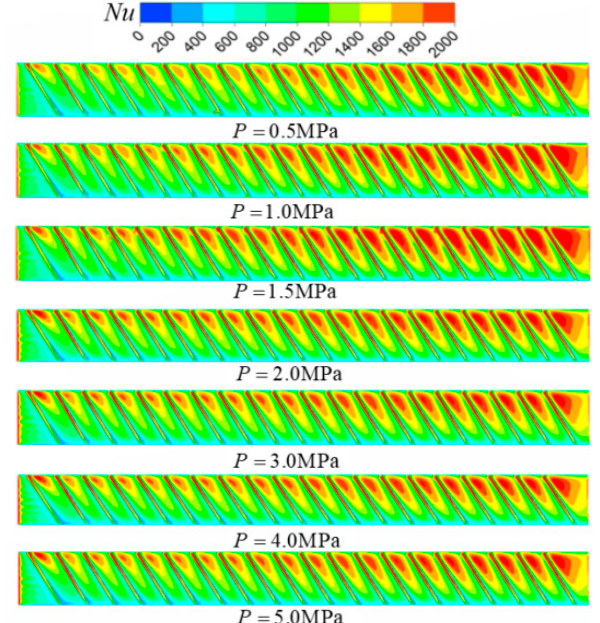
Figure 11. Variation in the Nusselt number distribution of the mist / steam cooling channel with the operating pressure.